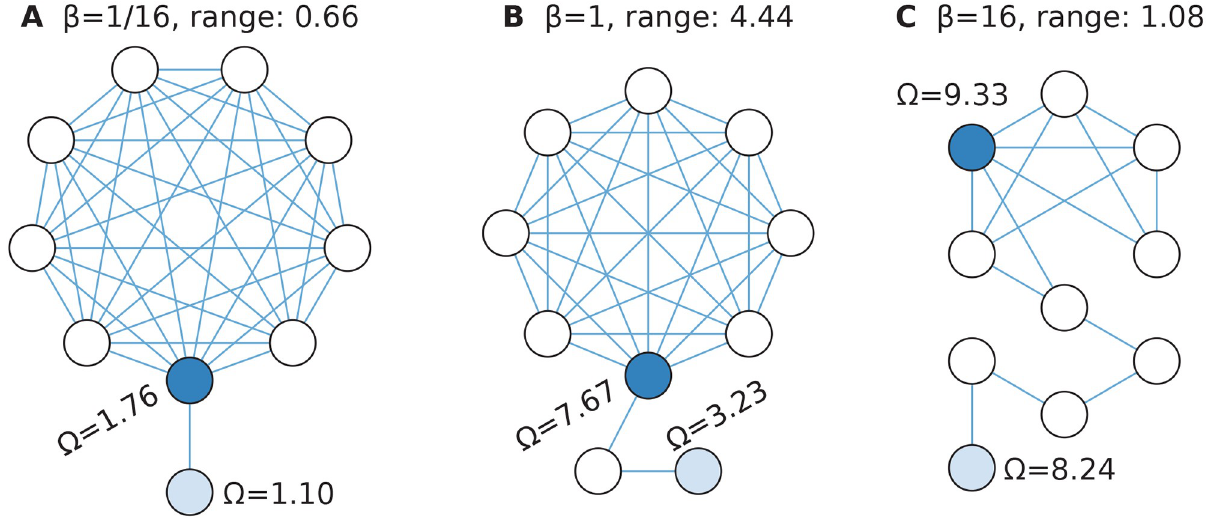
Fig 6. Example graphs with large O diversity. Panel A shows the graph with largest range of O values for β = 1/16; B for β = 1 and C for β = 16.